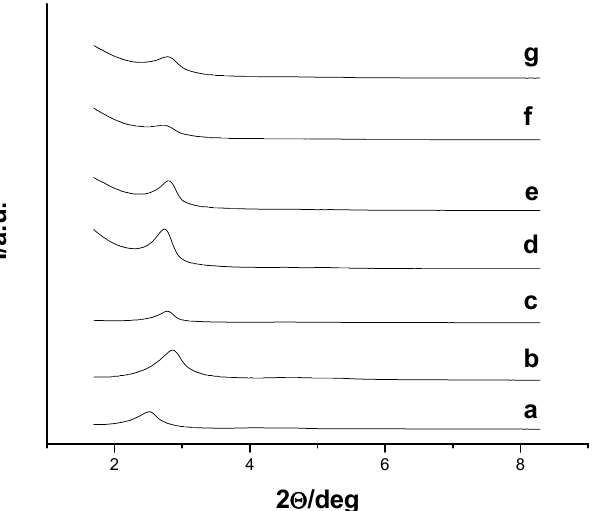
Figure 2. Powder X-ray diffraction patterns of the scaffolds and systems: ( a ) MCM-41 type as-made, ( b ) MSN, ( c ) MSN-Eu, ( d ) Glucose-MSN-Eu, ( e ) Maltose-MSN-Eu, ( f ) Maltodextrin-MSN-Eu and ( g ) Starch-MSN-Eu.